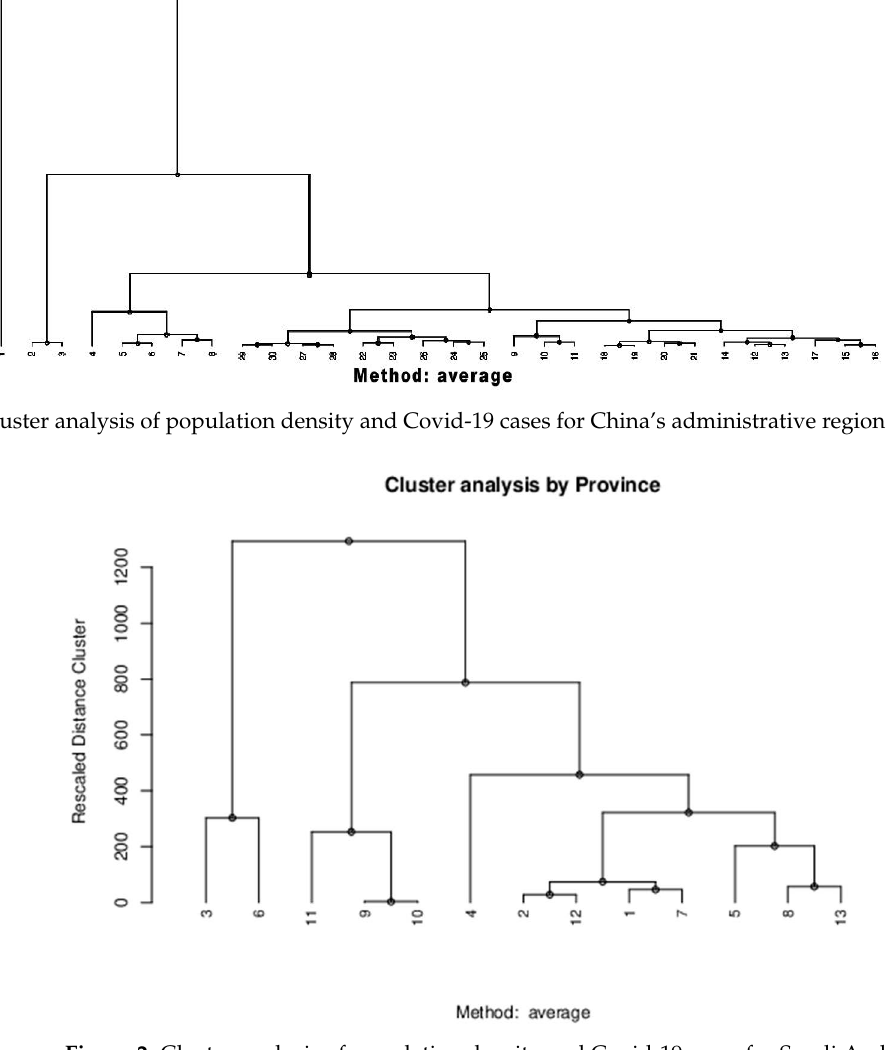
Figure 2. Cluster analysis of population density and Covid-19 cases for Saudi Arabia’s administra- tive